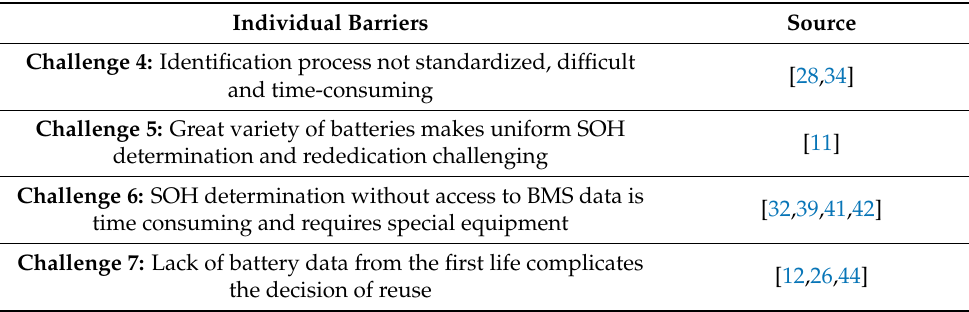
Table 2. The main barriers regarding screening. Individual